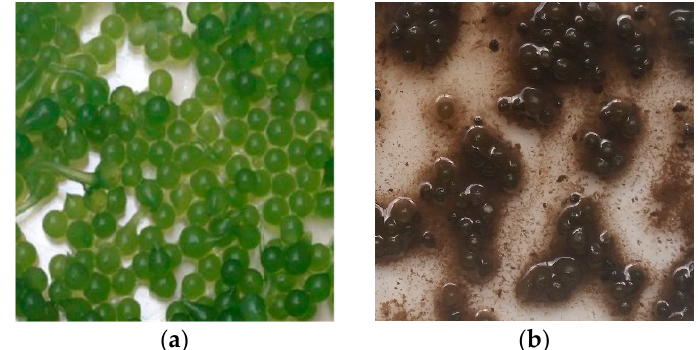
9 of 15 Figure 6. pH values observed during the repeated fed-batch culture cultivation of microalgae. The lines indicate the days when the culture was fed with a new dose of wastewater. The analysis of the data presented in Figure 6 indicated that over time the pH value of wastewater decreased in all samples, from the initial values in the range of pH = 7.8– 8.4 to the final values of pH ranging from 6.7 to 7.6. Similarly, to the tests carried out under static conditions, the fluctuation of the pH value was observed in dynamic conditions due to the ongoing metabolic processes in algal cells. The three-time exchange of wastewater portions for raw wastewater led to fluctuations in wastewater pH values, which is illus- trated by the increases and decreases in the pH values. In wastewater samples with the addition of immobilized microalgae N-NH 4+ , con- centrations were lower over the entire time range from those determined in samples of wastewater with a suspension of microalgae. On day 10, ammonium nitrogen concentra-